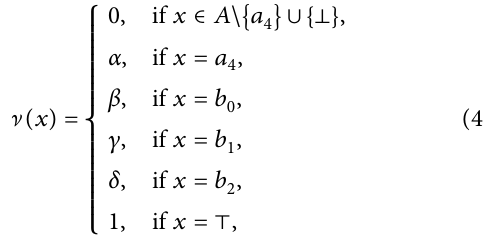
Figure 3: Hasse diagram of L